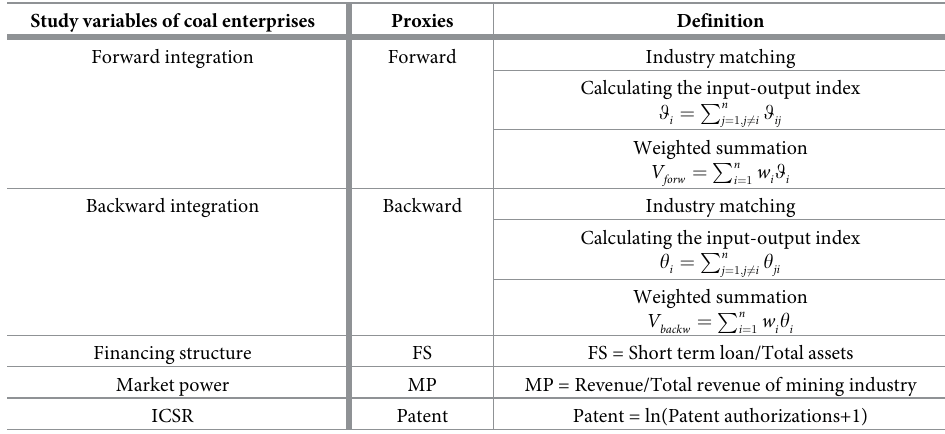
Table 1. Indicators of different study